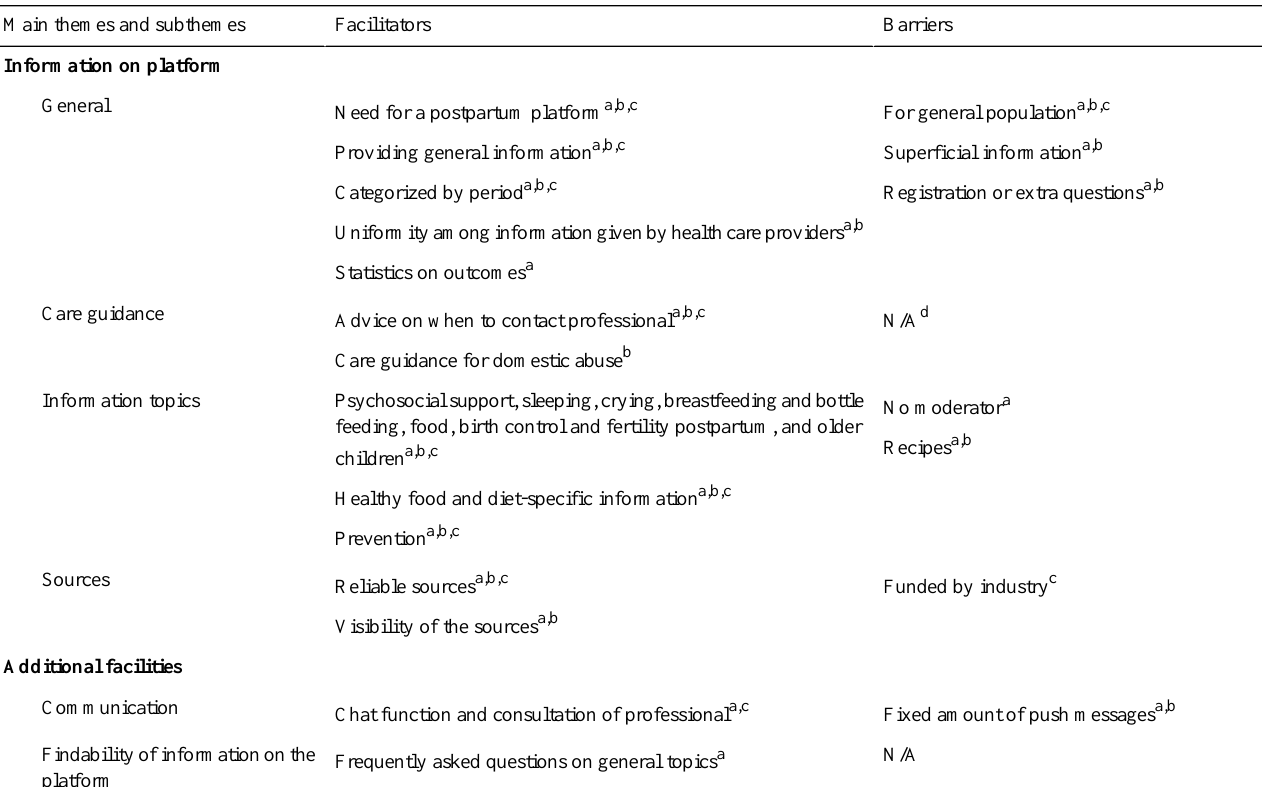
Table 4. Main themes, subthemes, facilitators, and barriers. BarriersFacilitatorsMain themes and